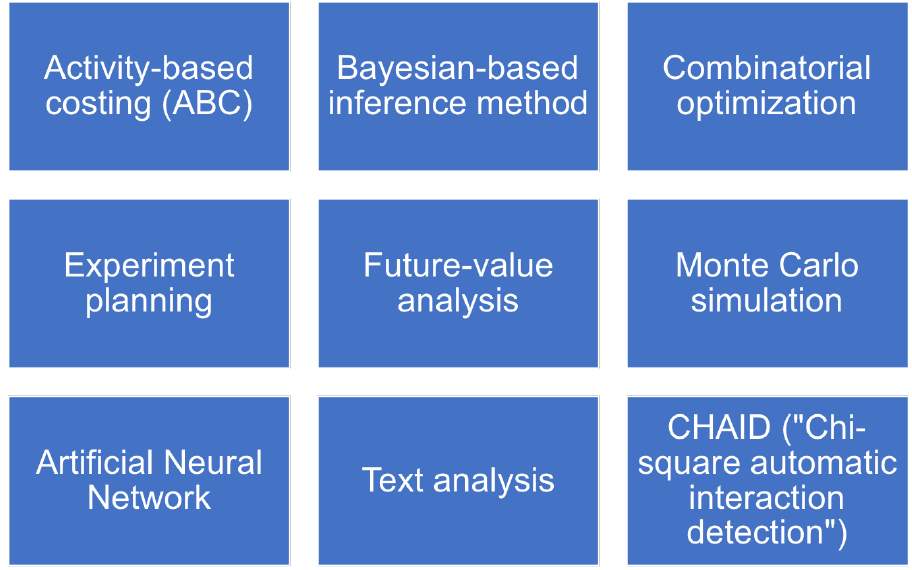
Figure 1. Different tools and methods a company can use on their data, based on our literature